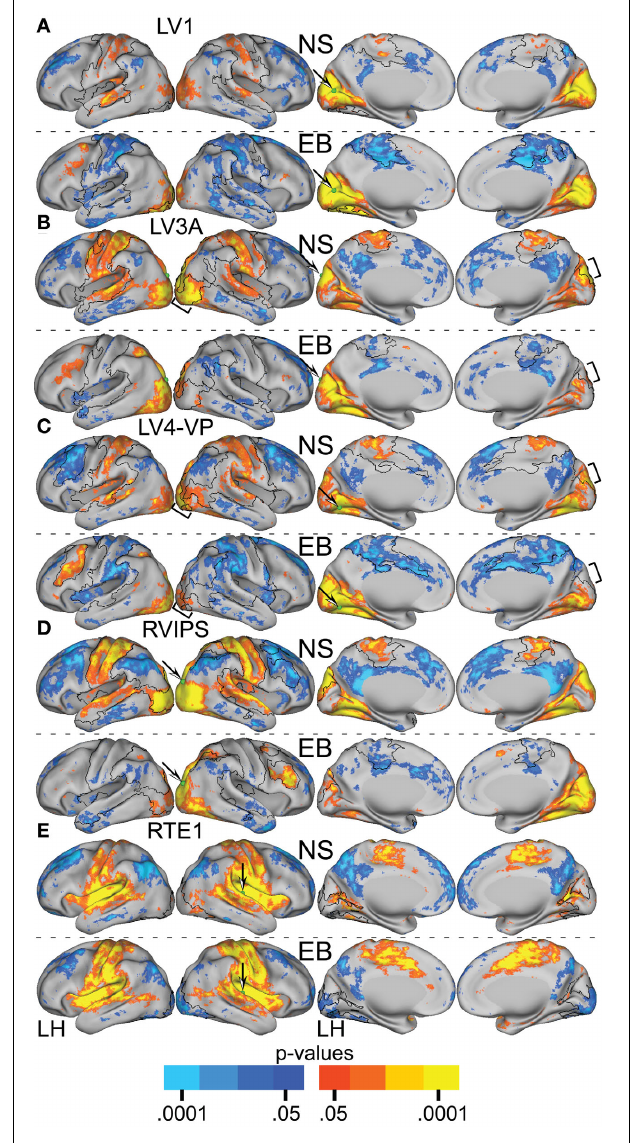
FIGURE 4 | Resting-state functional connectivity random effect Z ( r ) maps in normally sighted (NS) and early blind (EB) associated with selected sensory seed regions identified in Table 2. In NS, all seed regions in visual cortex (A–D) showed positively correlated connectivity with other sensory cortical regions. In EB, these same seed regions showed positive correlations only within visual cortex and negatively correlated connectivity with non-visual somatosensory and auditory regions. Seed regions in non-visual sensory cortex, e.g., auditory RTE1, (E) similarly showed positive correlations with other sensory cortex in NS. In EB, connectivity correlations with occipital cortex were negative but positive elsewhere as in NS. An arrow points at a green sphere that marks the location of the seed region in each map. Orange-Yellow painted in cortex with positive correlations having p -values of 0.05 to < 0.0001. Dark to light blue painted in cortex with negative correlations having p -values of 0.05 to < 0.0001. Black borders surround significant contiguous clusters identified using the threshold-free cluster enhancement assay (see Figure 5